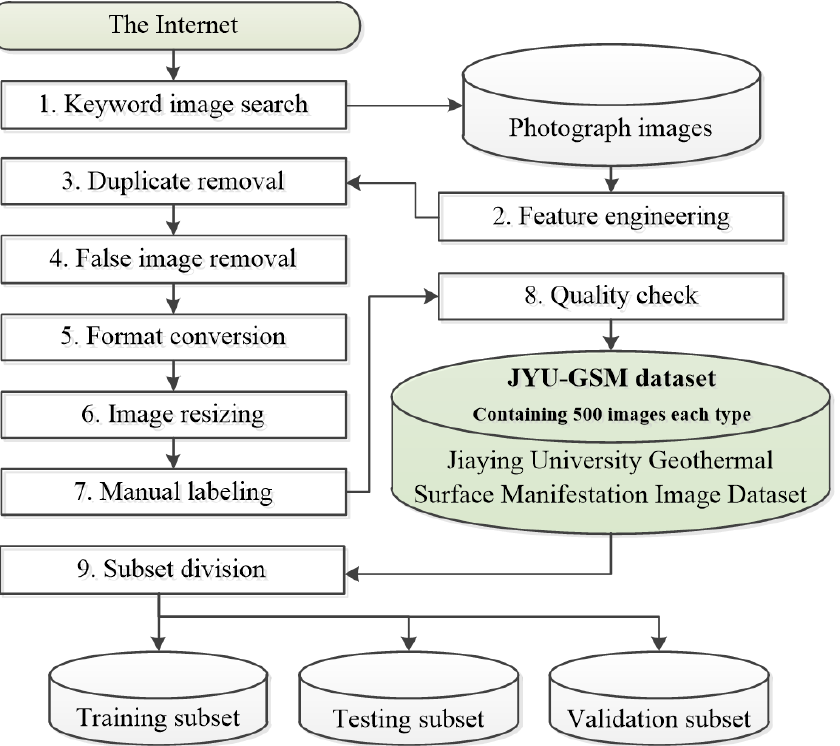
Figure 3. Workflow chart of the data preparation and preprocessing. JYU-GSM is the abbreviation for the JiaYing University Geothermal Surface Manifestation photographs dataset.